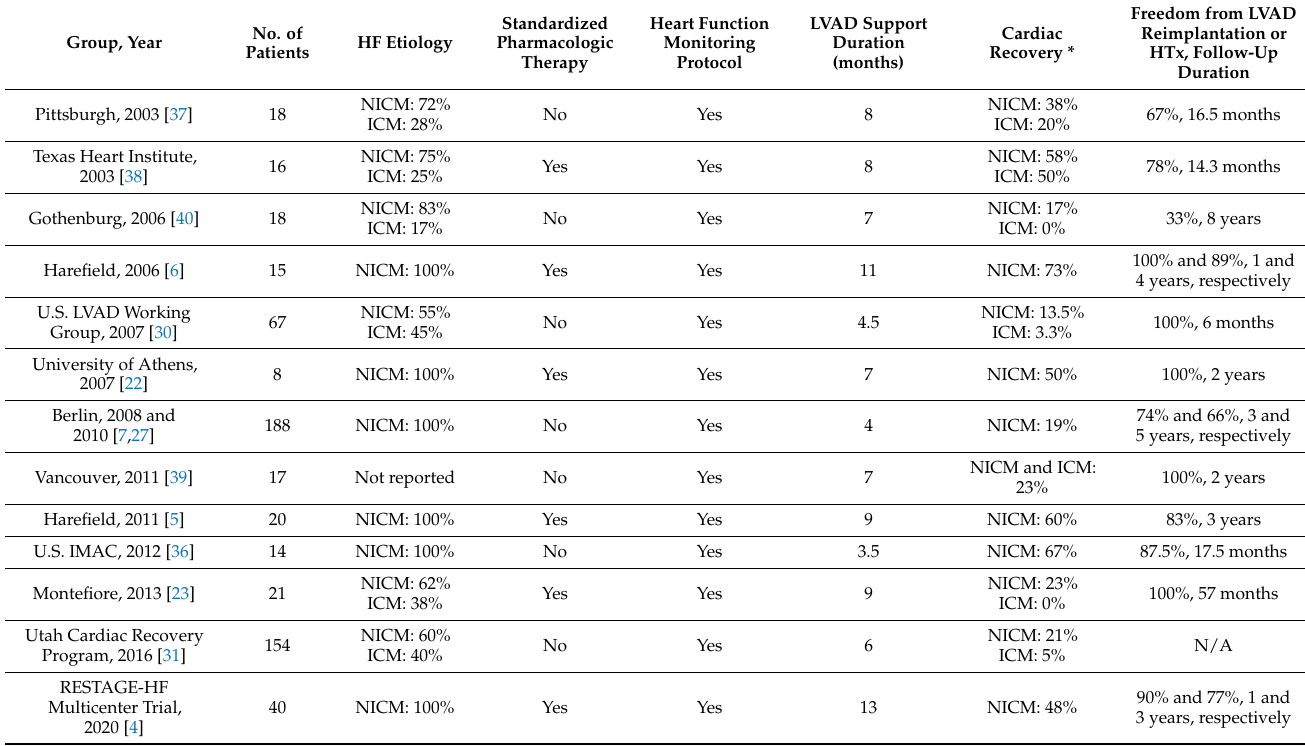
Table 1. Prospective Studies Investigating Cardiac Functional and Structural Improvement during Chronic LVAD